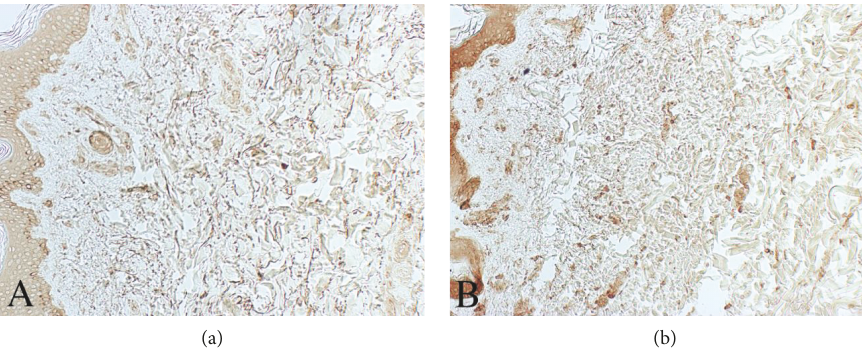
Figure 4: Representative skin samples from control subject (a) and MDE patient (b) after immunoreaction for MMP-1. As can be appreciated, a strong reaction for MMP-1 is found in the upper and middermis of the MDE tissue. Original magni fi cation ×